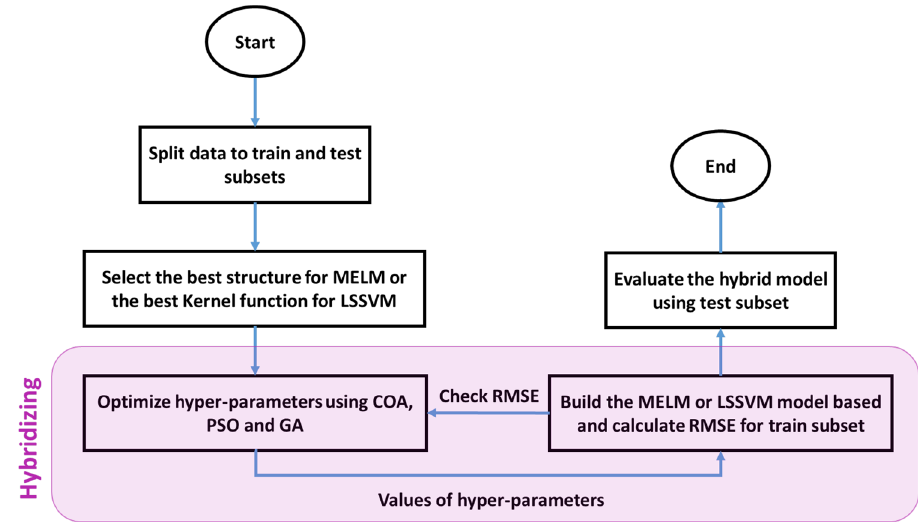
Fig. 2 Hybridization of predic- tor and optimizer algorithms for modeling the